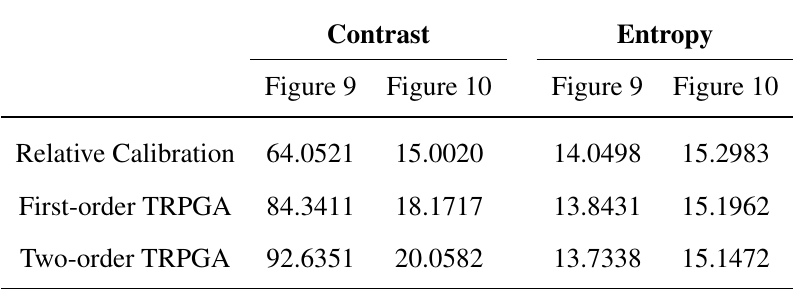
Table 3. Performance comparison of the images in Figures 9,10.